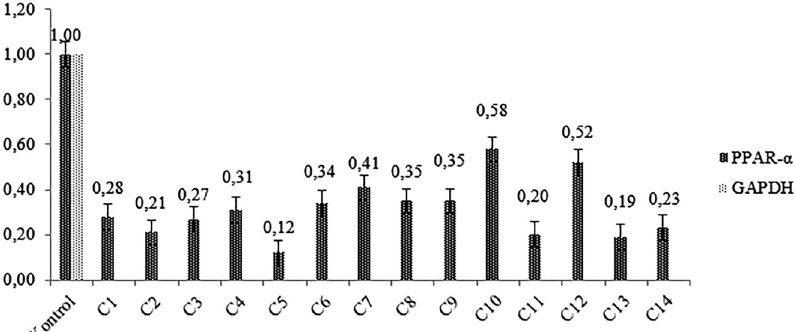
Figure 1: PPARA expression fold change.